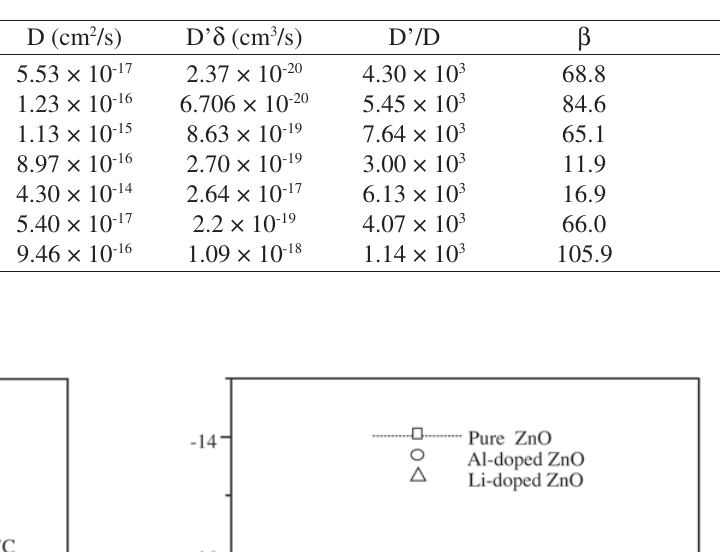
Table 1. Oxygen diffusion in pure and doped ZnO